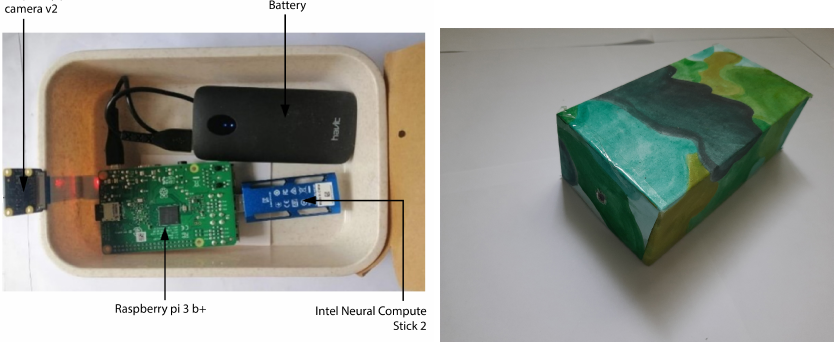
Figure 4. High-tier model ( left ): Internal view, ( right ): Exterior deployment